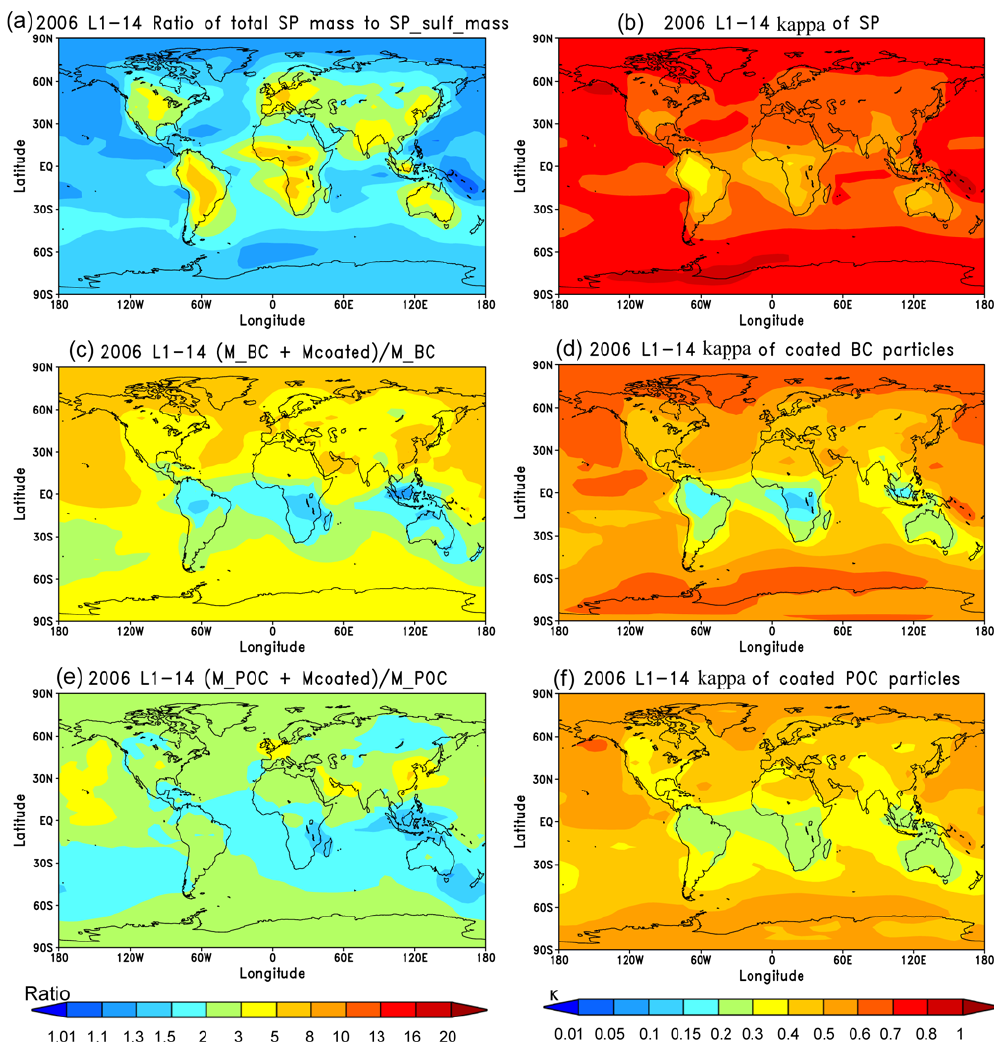
Fig. 4. Ratio of total mass (core component + coated SS) to the mass of core component as well as hydroscopicity parameter ( κ) for SP, coated BC, and coated POC, averaged within the first 2km (model layer 1–14) of atmosphere above the